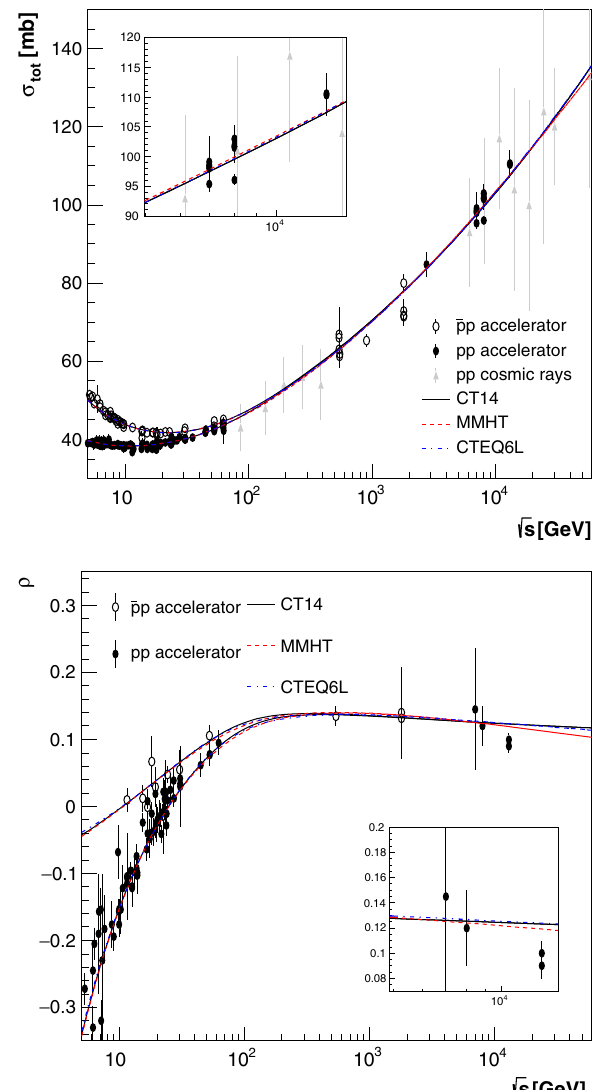
/ ¯ pp ρ pp / ¯ pp data without the ATLAS Fig. 7 Global 1 σ -fit to σ pp √ tot and s min = 10 GeV measurements, for low-energy cutoff Table 8 Best-fit parameters of our model without ATLAS data and √ s min = 5.0 GeV. The number of degrees of freedom low-energy cutoff